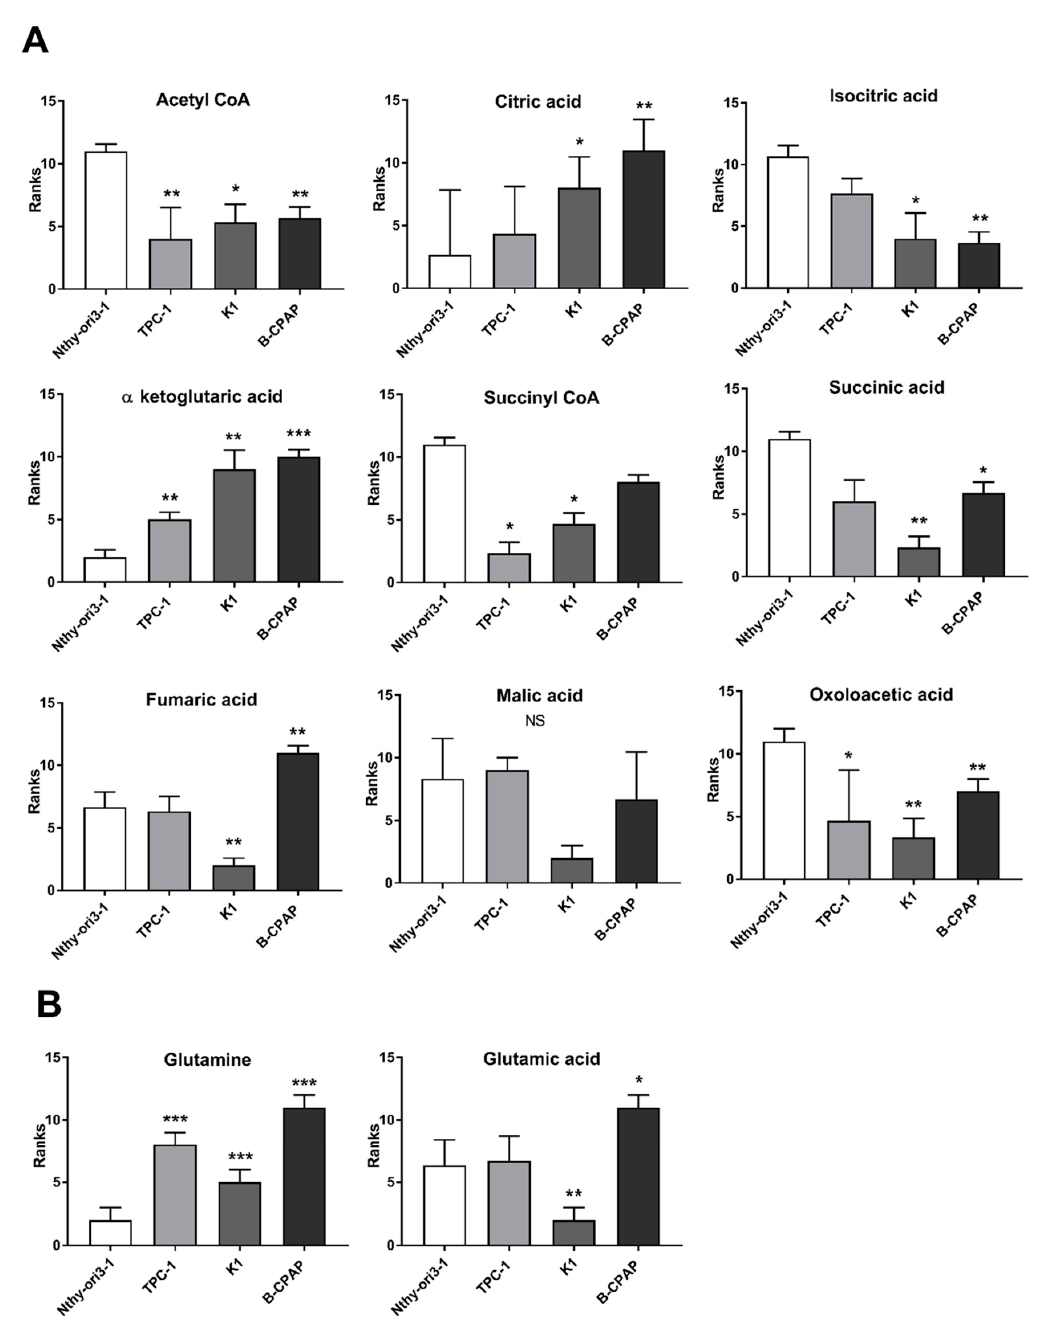
Figure 2. Tricarboxylic acid cycle (TCA) and glutaminolysis pathways in PTC-derived cells . Metabolic alterations in TCA cycle ( A ) and glutaminolysis ( B ) measured using UHPLC-MS/MS. Bar graphs indicate the relative concentration of the metabolites. All experiments were performed three times independently, each time in triplicate to confirm the results. Statistical analyses were performed by Student t -test. Results were considered significant when * p < 0.05, ** p < 0.01, *** p < 0.001.